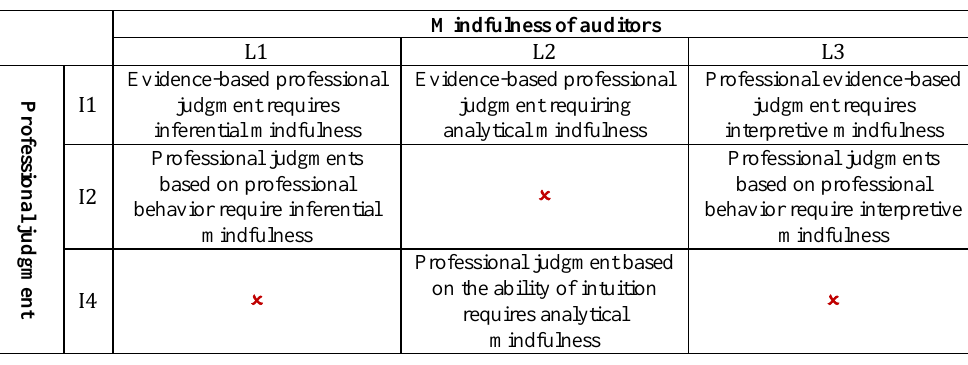
Table 8. interpretive analysis of the matrix of auditors 'professional judgment